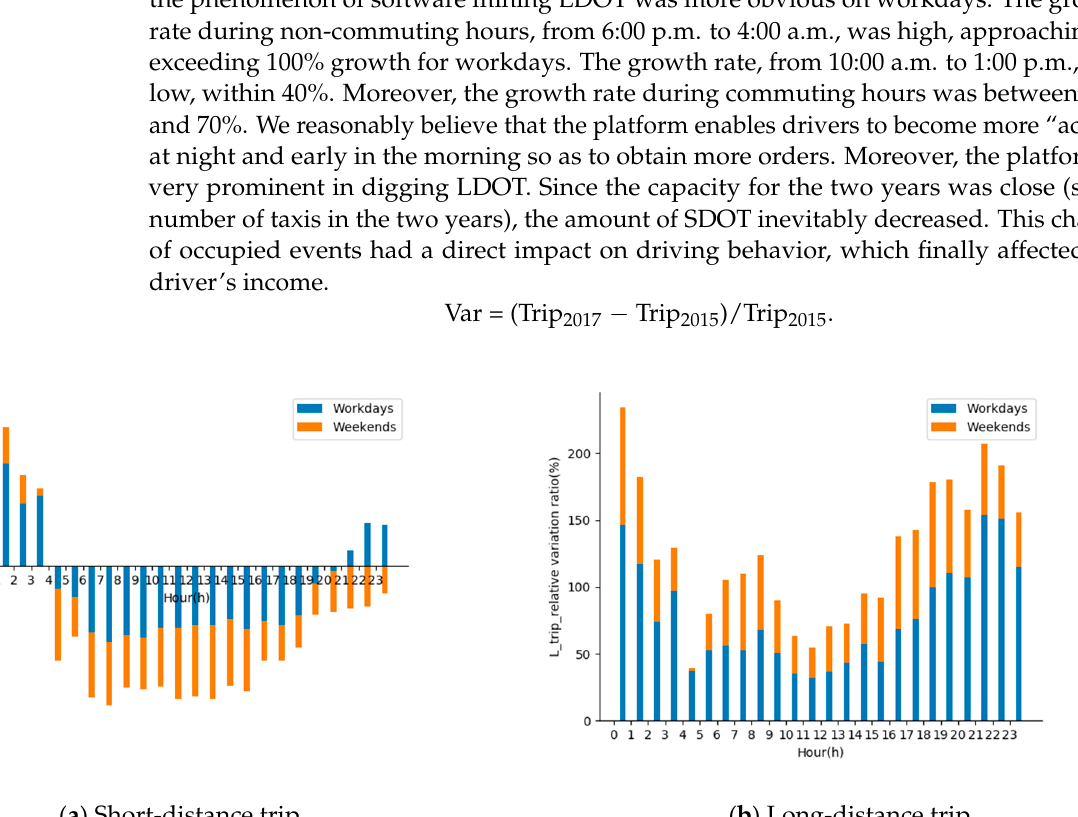
Figure 3. The relative difference between ( a ) short-distance and ( b ) long-distance occupied trips. The relative variation ratio refers to the trip growth rate between 2015 and 2017, and the growth formula is as shown in Formula (1). If the y-valve > 0, then the growth in the number of trips was more than 0% and the number of trips increased. Instead, if the y-valve < 0, then the growth in the number of trips was below 0% and the number of trips decreased.